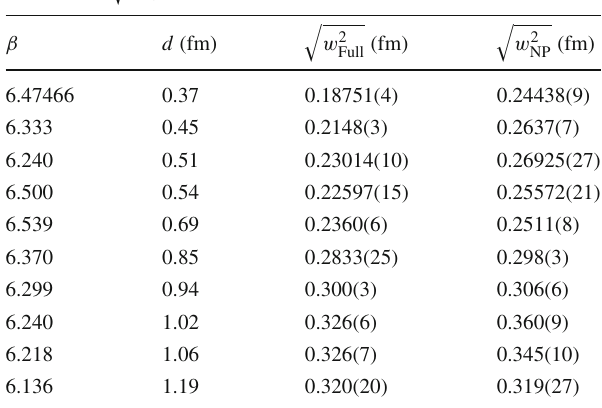
Table 6 The width of the diagonal component of the Maxwell stress tensor recovered from the full field E x ( ( NP ) field E x